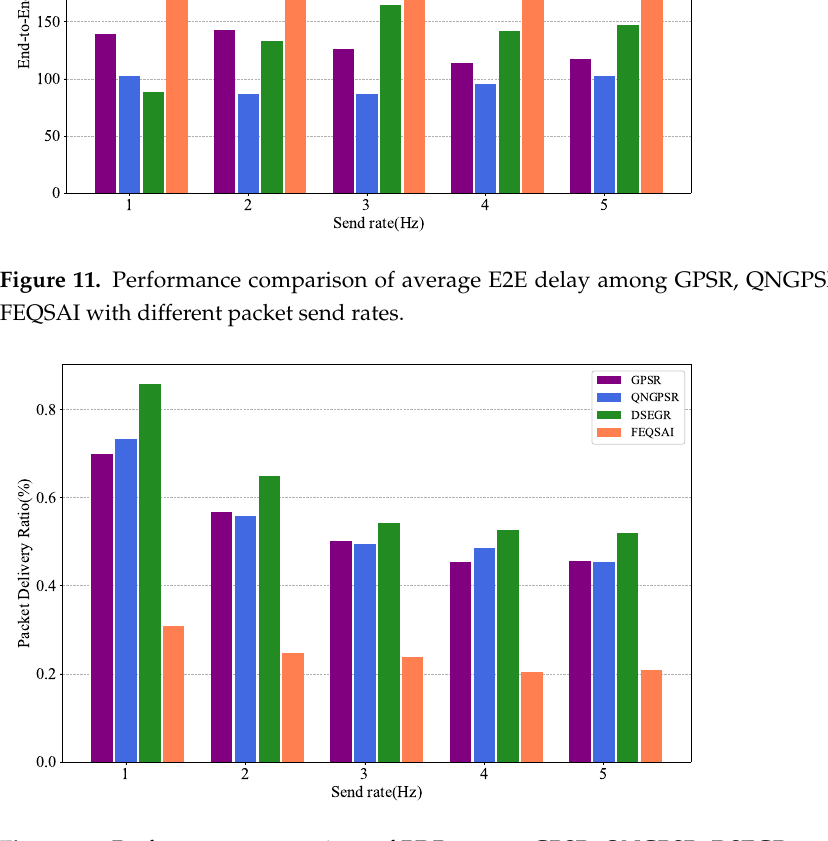
Figure 12. Performance comparison of PDR among GPSR, QNGPSR, DSEGR, and FEQSAI with different packet send rates.